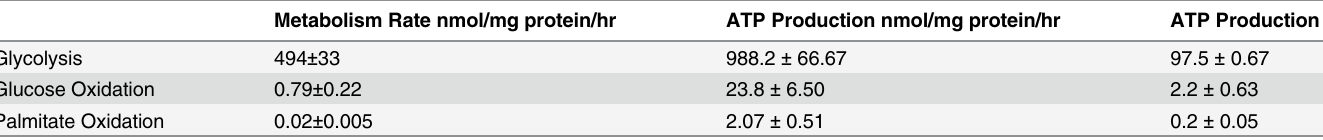
Table 1. Contribution of energy metabolism pathways to ATP production in human